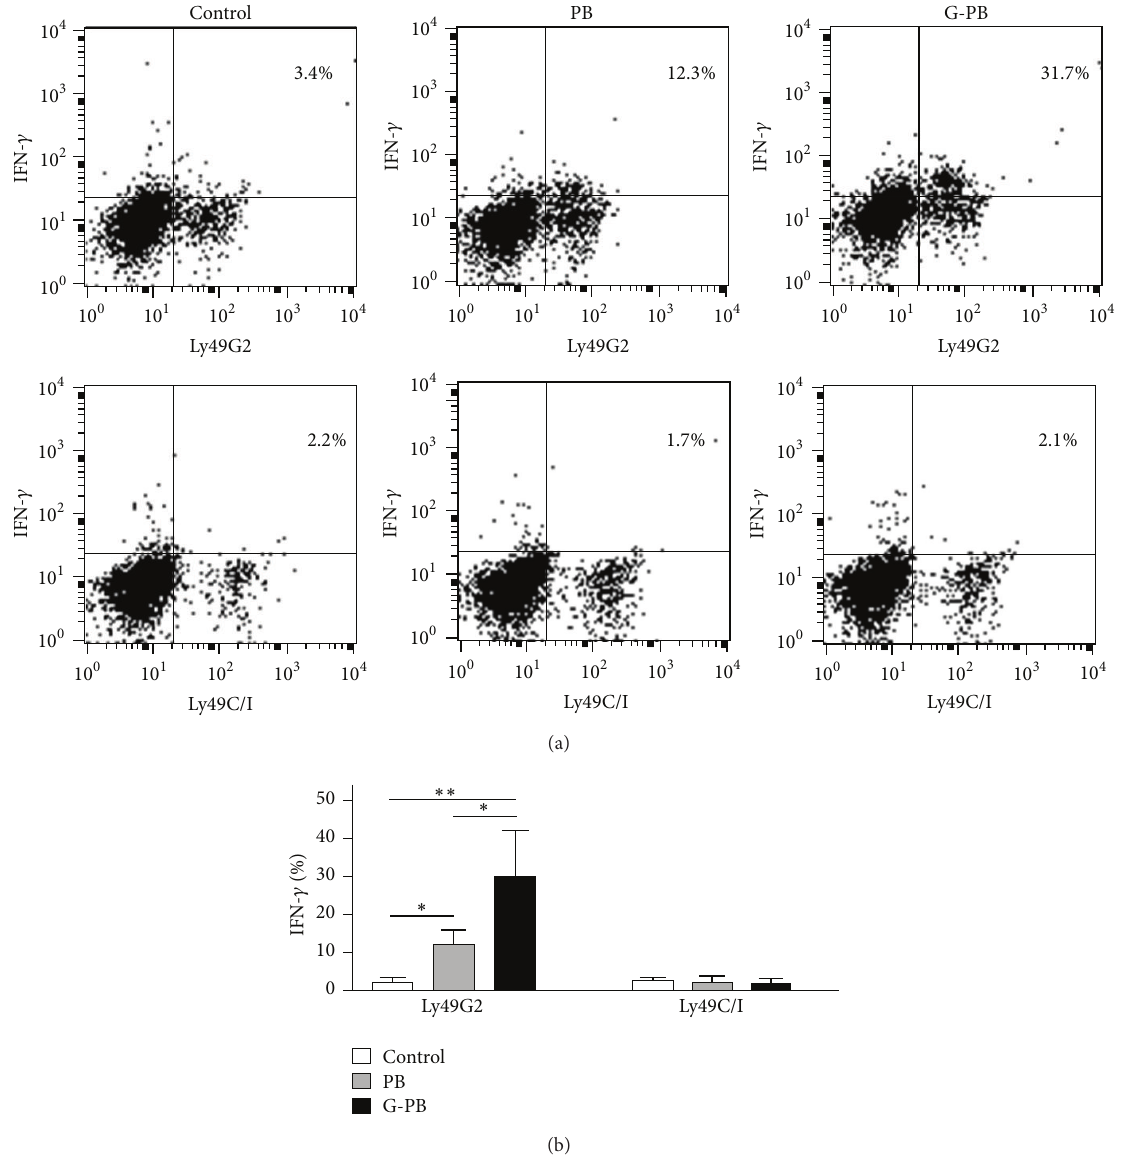
Figure 3: Neutrophils promote a licensing effect of NK cells: upregulation of intracellular IFN- 𝛾 expression. Forty Gy-irradiated 2 × 10 6